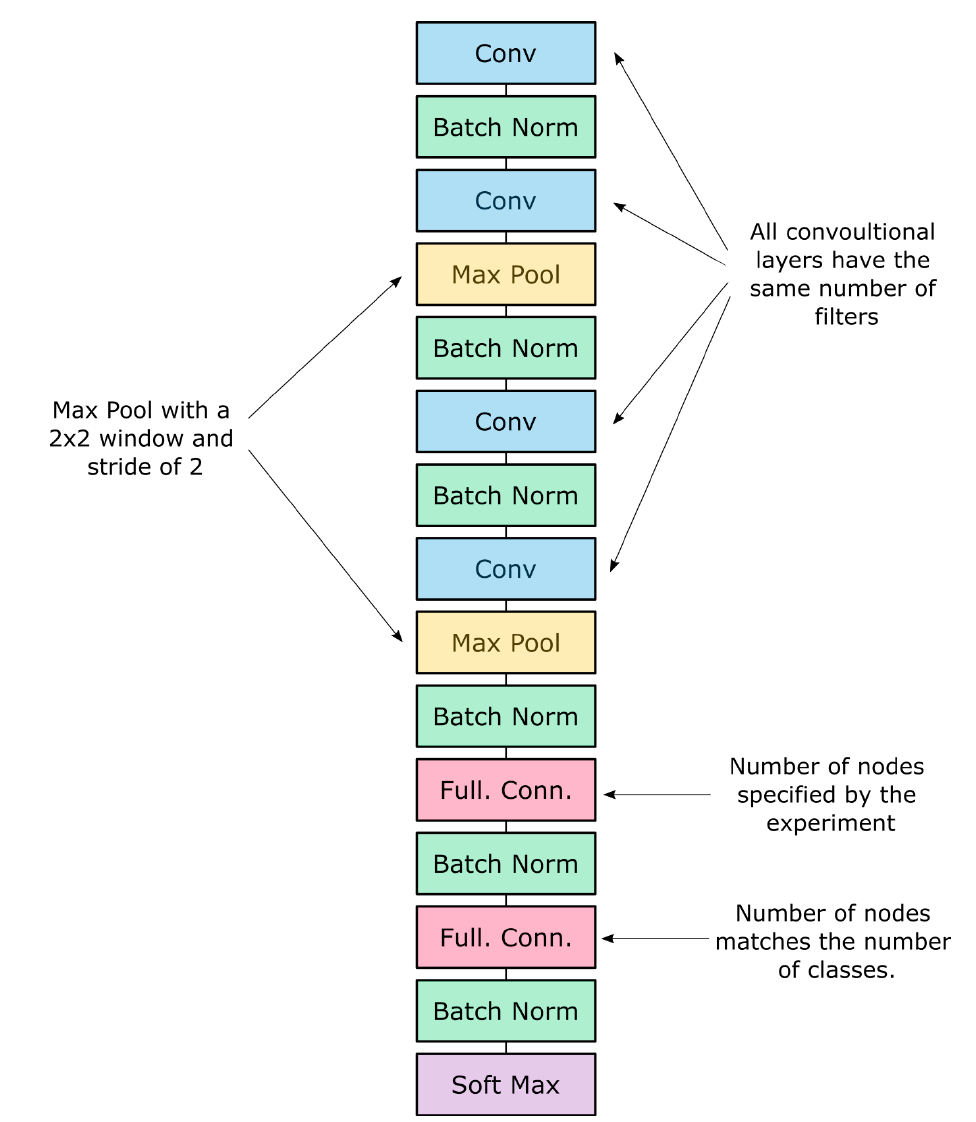
Figure 7. The model topology used for all experiments. The number of filters in the convolutional layers and the number of nodes in the first fully connected layer change per experiment.